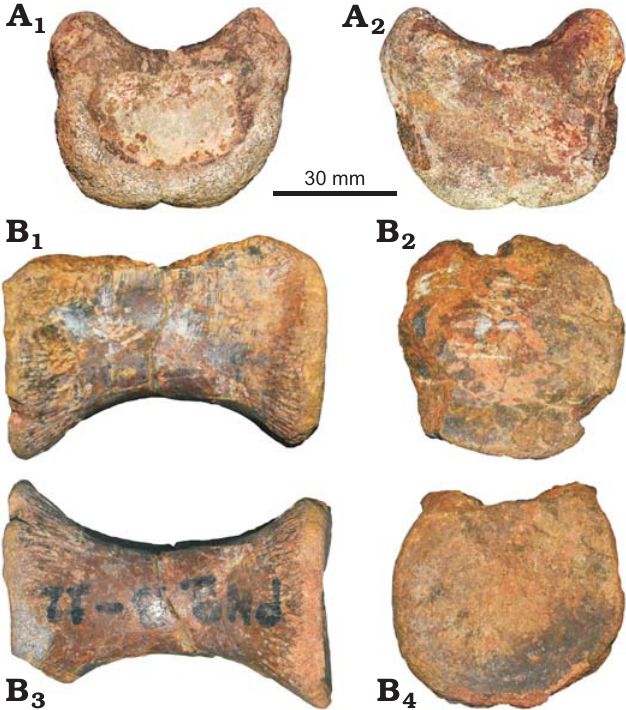
Fig. 3. Coelurosaurian theropod Phuwiangvenator yaemniyomi gen. et sp. nov. from the Early Creta ceous Sao Khua Formation of Phu Wiang, Khon Kaen Province, Thailand. A . SM-PW9A-1, atlantal intercentrum in anterior (A 1 ) and posterior (A 2 ) views. B . SM-PW9B-12, dorsal vertebra in left lat- eral (B 1 ), anterior (B 2 ), ventral (B 3 ), and posterior (B 4 )